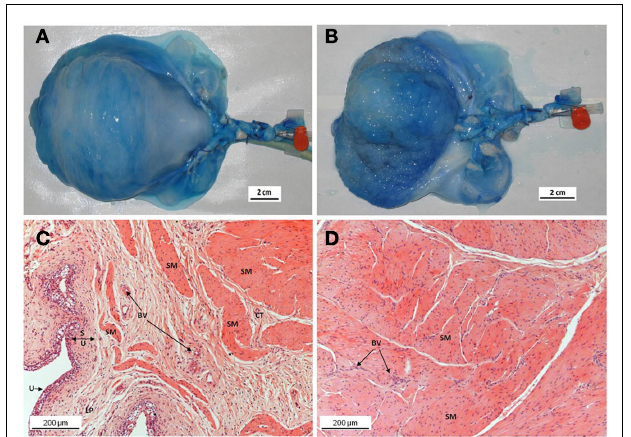
FIGURE 1 |Top panel: Perfusion of the bladder with methylene blue through the internal iliac trunk showing effective distribution to the serosa, detrusor, and urothelium: (A) serosal staining, (B) internal staining. Bottom panel: H&E stained sections from paraffin-embedded intact pig bladder dome biopsies after 8h of perfusion.The fine chromatin structure demonstrates well-preserved tissue with no signs of autolysis in the urothelium (C) , sub-urothelium (D) , or smooth muscle cells (C,D) . SM, smooth muscle; BV, blood vessels; LP, lamina propria; CT, connective tissue; S, sub-urothelium; U,